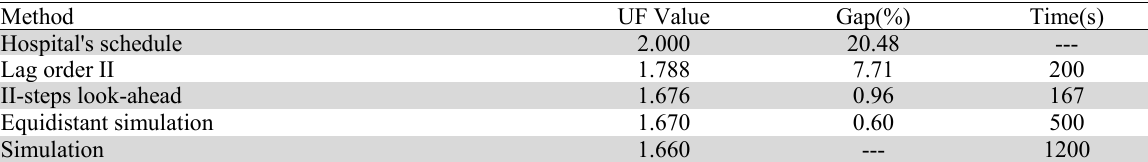
The schedule results for a CT-scan Method UF Value Gap(%) Time(s) Hospital's schedule 2.000 20.48 --- Lag order II